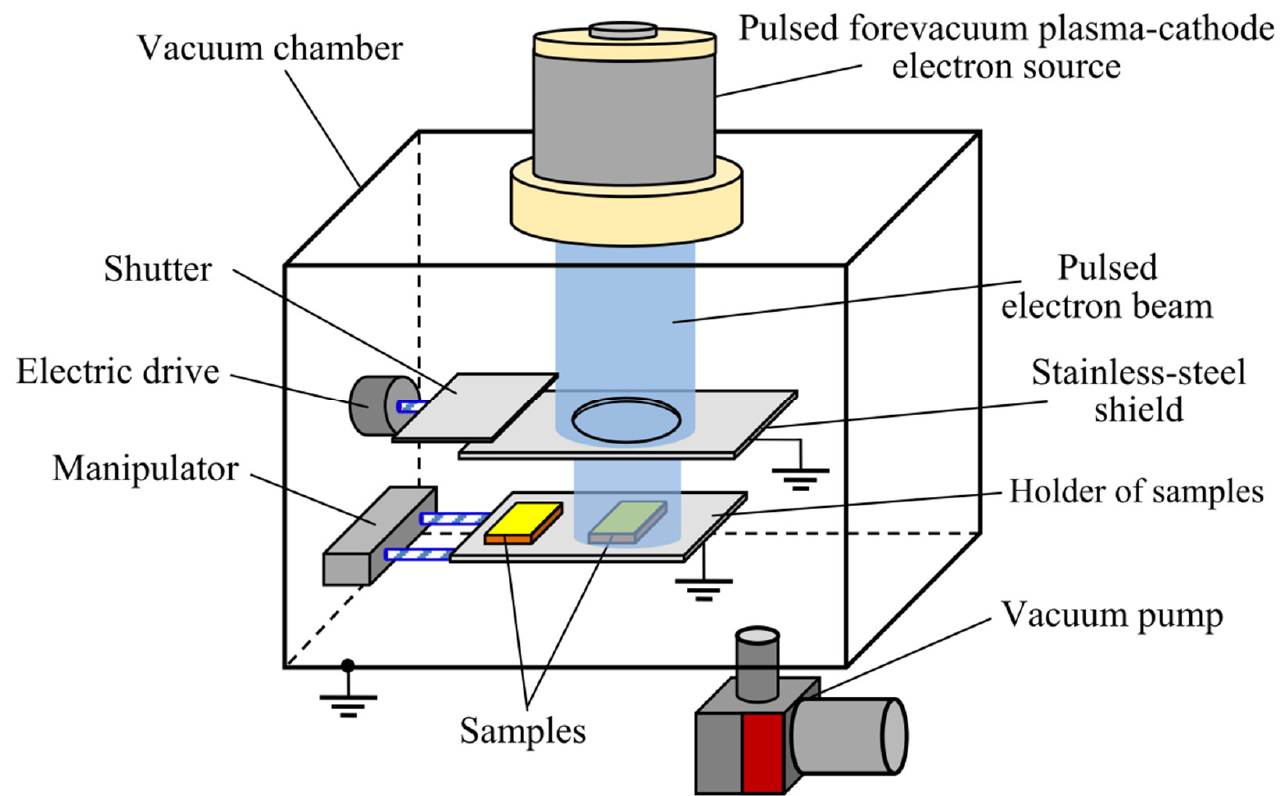
Figure 2. Setup for the modification of boron coatings with a pulsed electron beam.